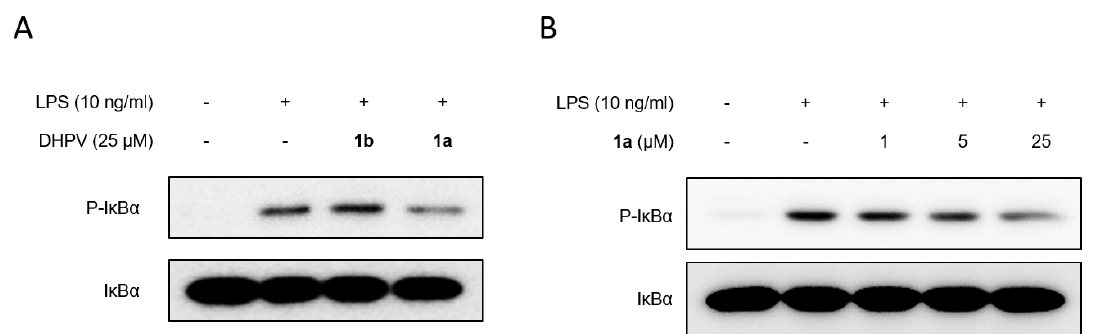
Figure 2. Biological activity of synthesized ( R )- and ( S )-DHPV. ( A ) The effects of 1b ( R )-DHPV (25 μ M) and 1a ( S )-DHPV (25 μ M) on the phosphorylation and degradation of I κ B α were determined by Western blot analysis in IEC-6 cells exposed to lipopolysaccharides (LPS; 10 ng/mL) for 1 h. ( B ) The effect of 1a ( S )-DHPV on the expression of phosphorylation and degradation of I κ B α was analyzed dose dependently by Western blot analysis in LPS (10 ng/mL)-treated IEC-6 cells.